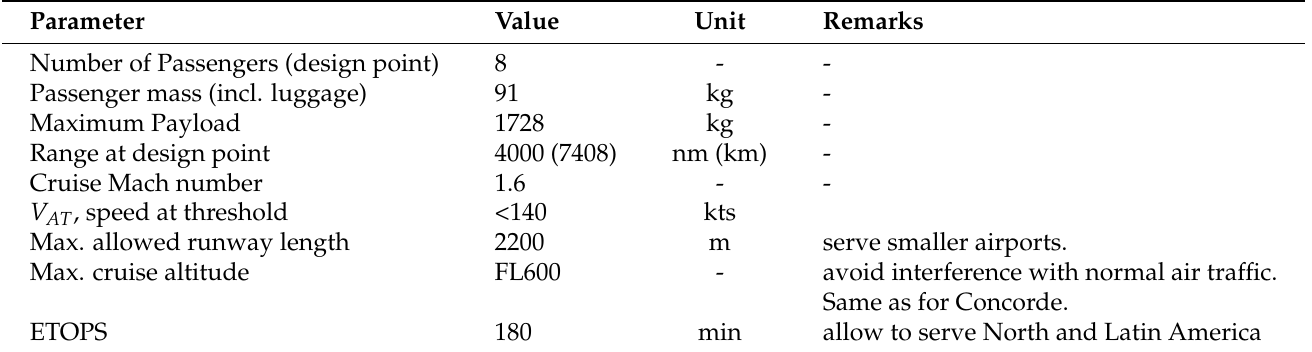
Table A2. Extract of the requirements from Ref. [14].